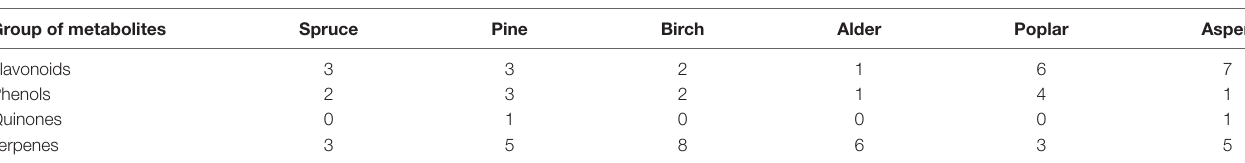
FIGURE 3 | Taxonomic structure of lichen assemblages on five phorophytes. (A) Crustose species, (B) foliose and fruticose species. TABLE 3 | Diversity of studied groups of metabolites in bark of